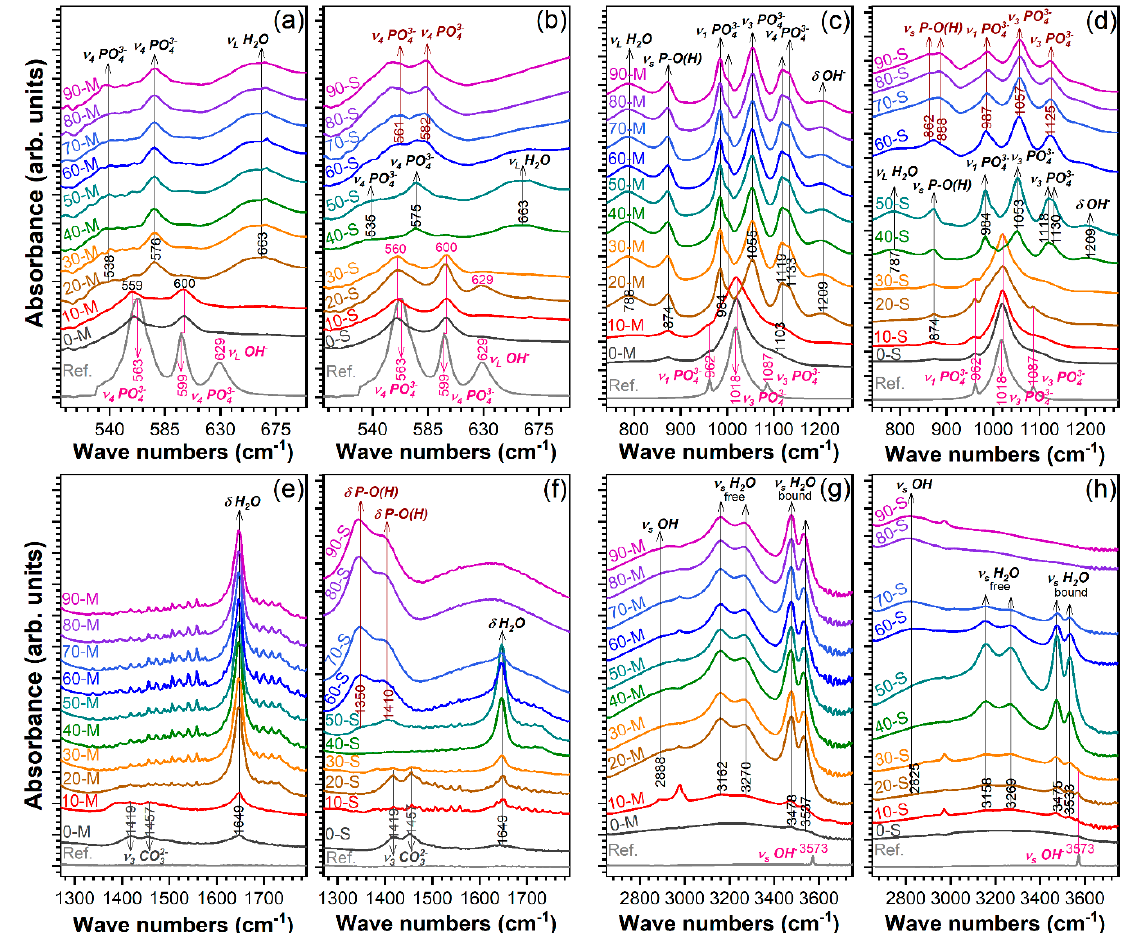
Figure 2. Comparative FTIR-ATR (attenuated total reflectance) spectra of the calcium phosphate powders synthesized using natural resources (i.e., ( a , c , e , g ) marble and ( b , d , f , h ) seashells) as calcium precursors and phosphoric acid amounts situated in the range 0–90%, collected in the four relevant wave numbers regions: ( a , b ) 700–500 cm − 1 ; ( c , d ) 1300–700 cm − 1 ; ( e , f ) 1800–1300 cm − 1 ; and ( g , h ) 3750–2650 cm − 1 . To facilitate a better visual evaluation, the FTIR-ATR spectra were normalized to the intensity of the most prominent band region situated at ~1100–900 cm − 1 .